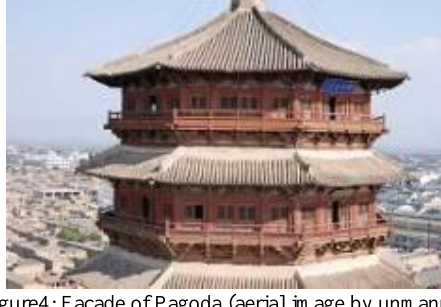
Figure6: birdview of St.Louis Cathedral